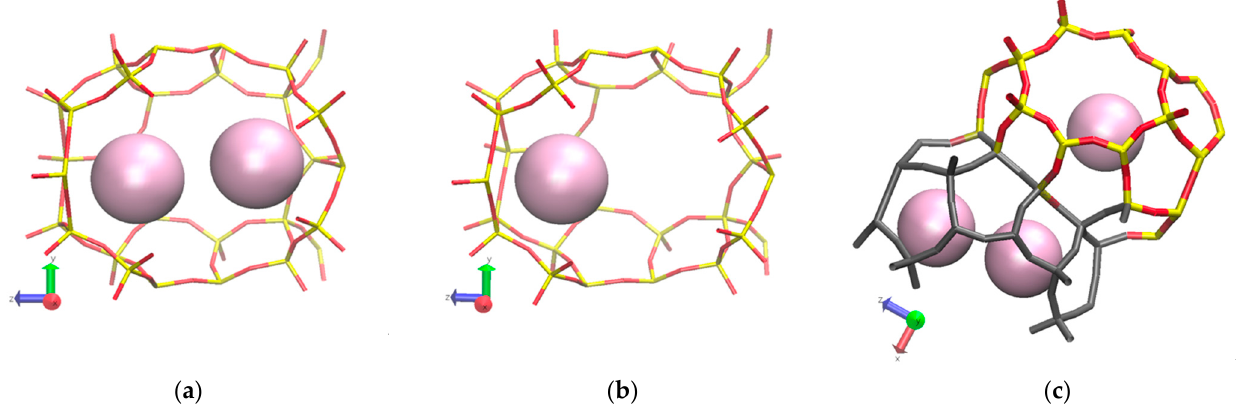
Figure 11. Molecular visualization of temperature effect on active adsorption site occupancy ( a ) at 300 K and 150 atm and ( b ) at 425 K and 75 atm. ( c ) Xe atom occupying inner cages at elevated temperatures validating the requirement of much longer simulation times. Color difference in membrane structure is to distinguish surface partial cages (gray) and inner cages (colored).